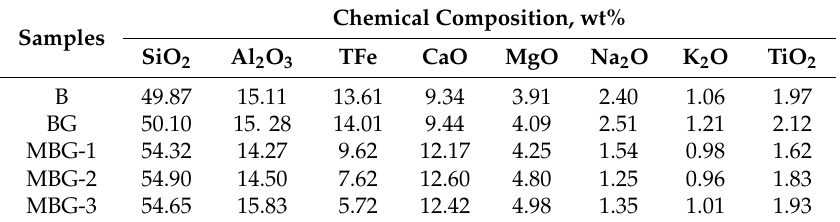
Table 2. Composition of the basalt (B), basalt glass (BG), and modified basalt glass (MBG).